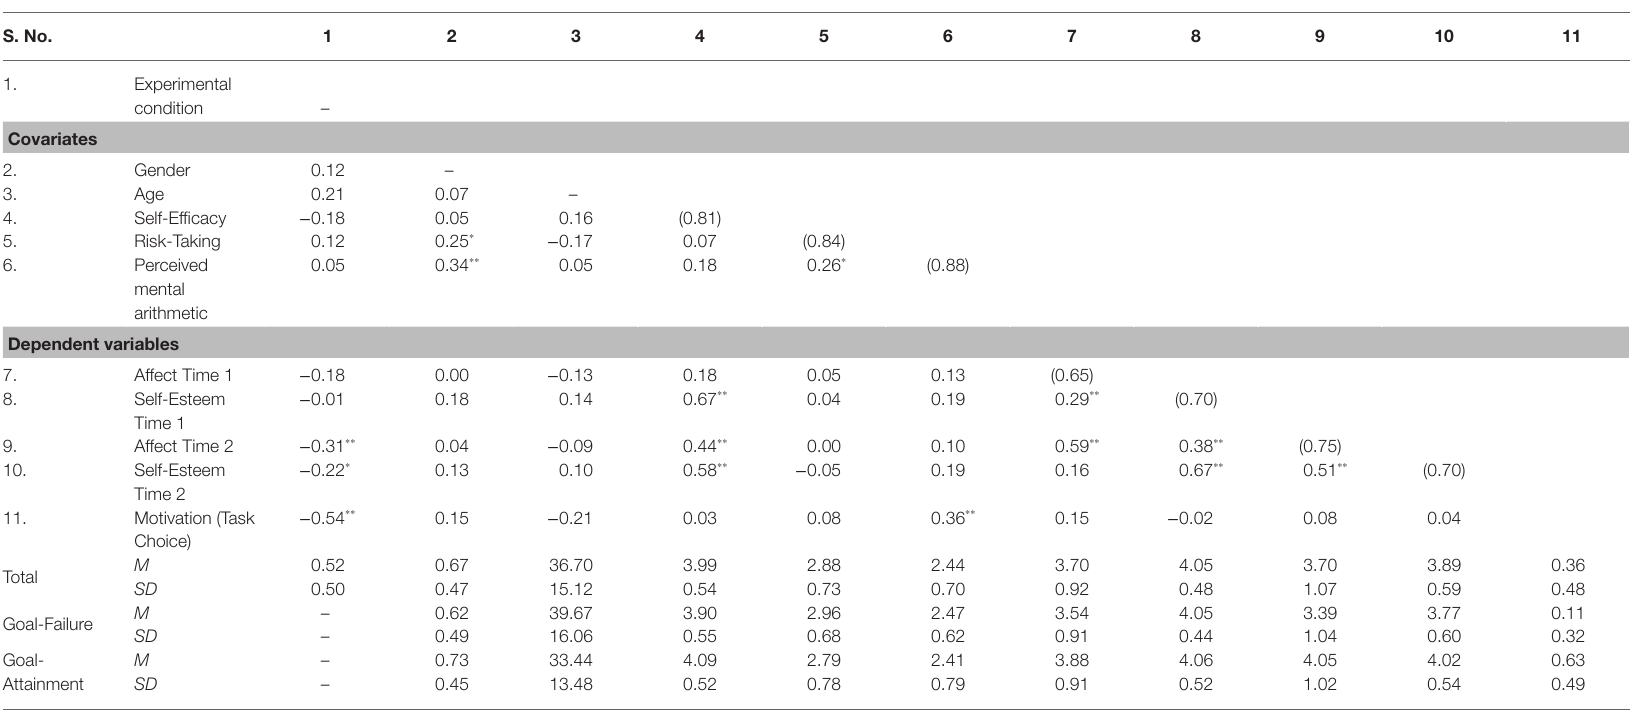
TABLE 5 | Descriptive statistics and bivariate correlations Study 2. S.